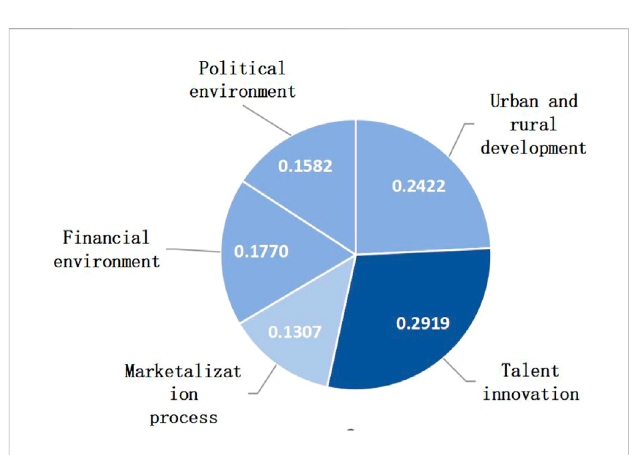
FIGURE 1 Weights of DB environment